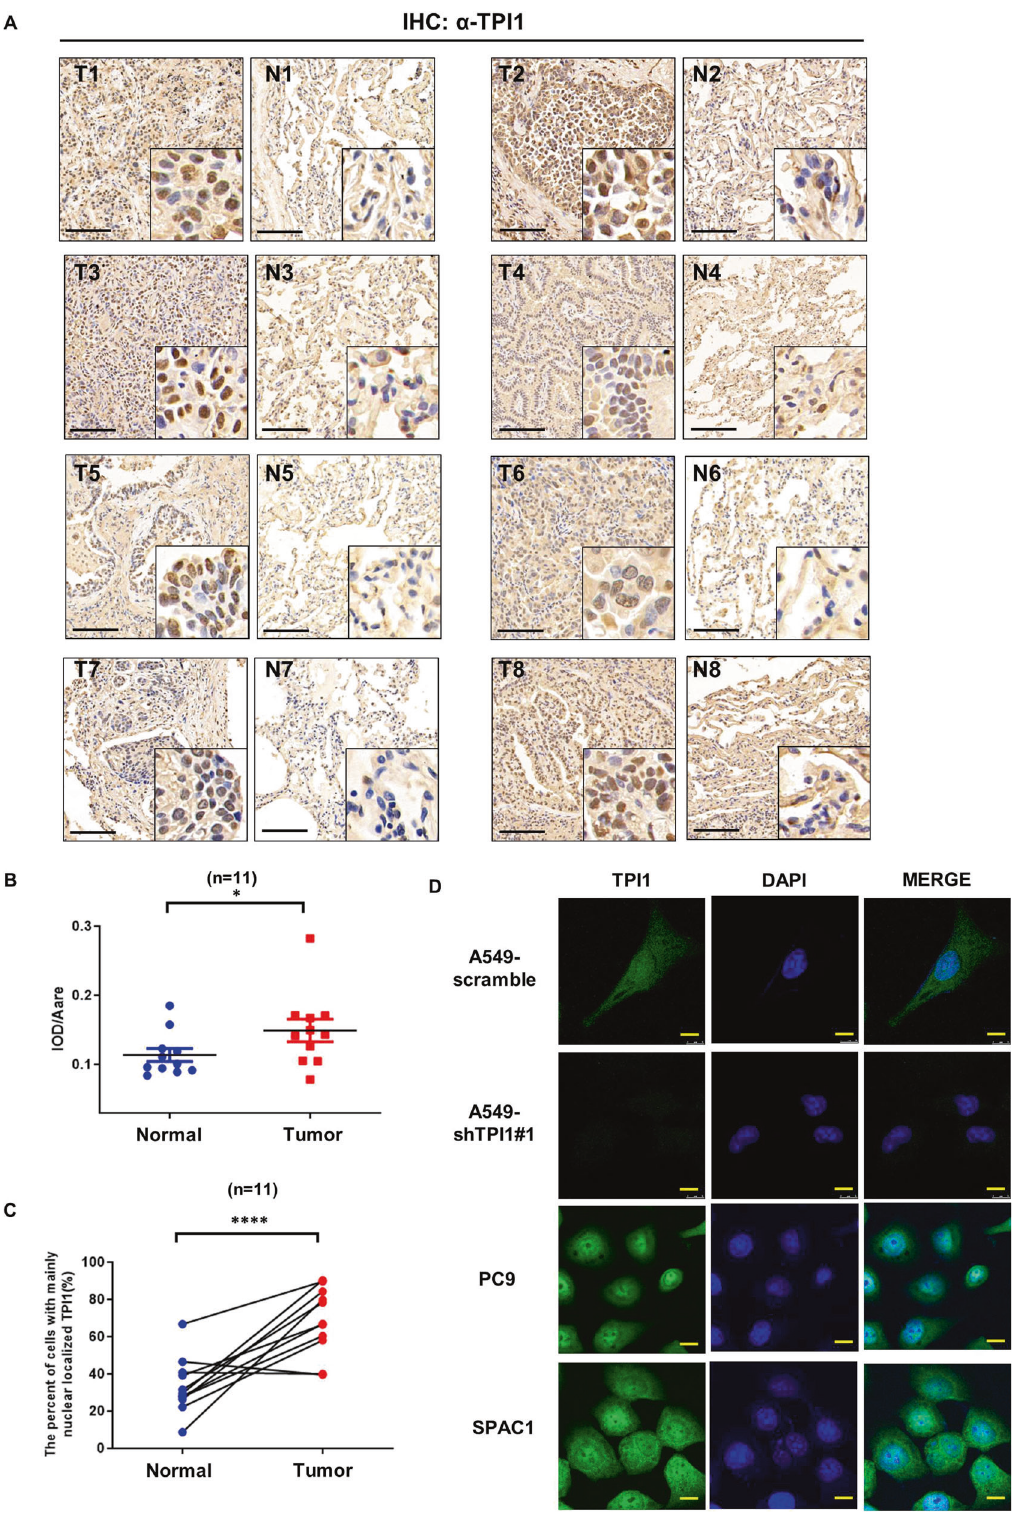
Fig. 4 TPI1 is predominantly localized in cell nucleus in LUAD samples. A Representative IHC staining of TPI1 in paired LUAD and adjacent normal tissues. Scale Bar: 50 μ m. B Quanti fi cation of TPI1 expression levels in IHC staining. The mean ratios of integrated optical density (IOD) to area (IOD/pixel) were used for analysis. Data are the mean ± SD from LUAD and adjacent normal tissues. Asterisks denote statistical signi fi cance with Student ’ s t -test. *p < 0.05. C Paired comparisons (Wilcoxon signed-rank test) of the percentage of cells with predominant nuclear localization of TPI1 revealed by IHC staining. Each line indicates the pair of tumor and adjacent normal tissue. **** p < 0.0001. D Localization of TPI1 in LUAD cell lines (A549, PC9, and SPAC1) revealed by Immuno fl uorescence staining. Notably, TPI1 signal was not detected in A549 cells with TPI1 knockdown, demonstrating the speci fi city of the antibody. Scale Bar: 10 μ m.